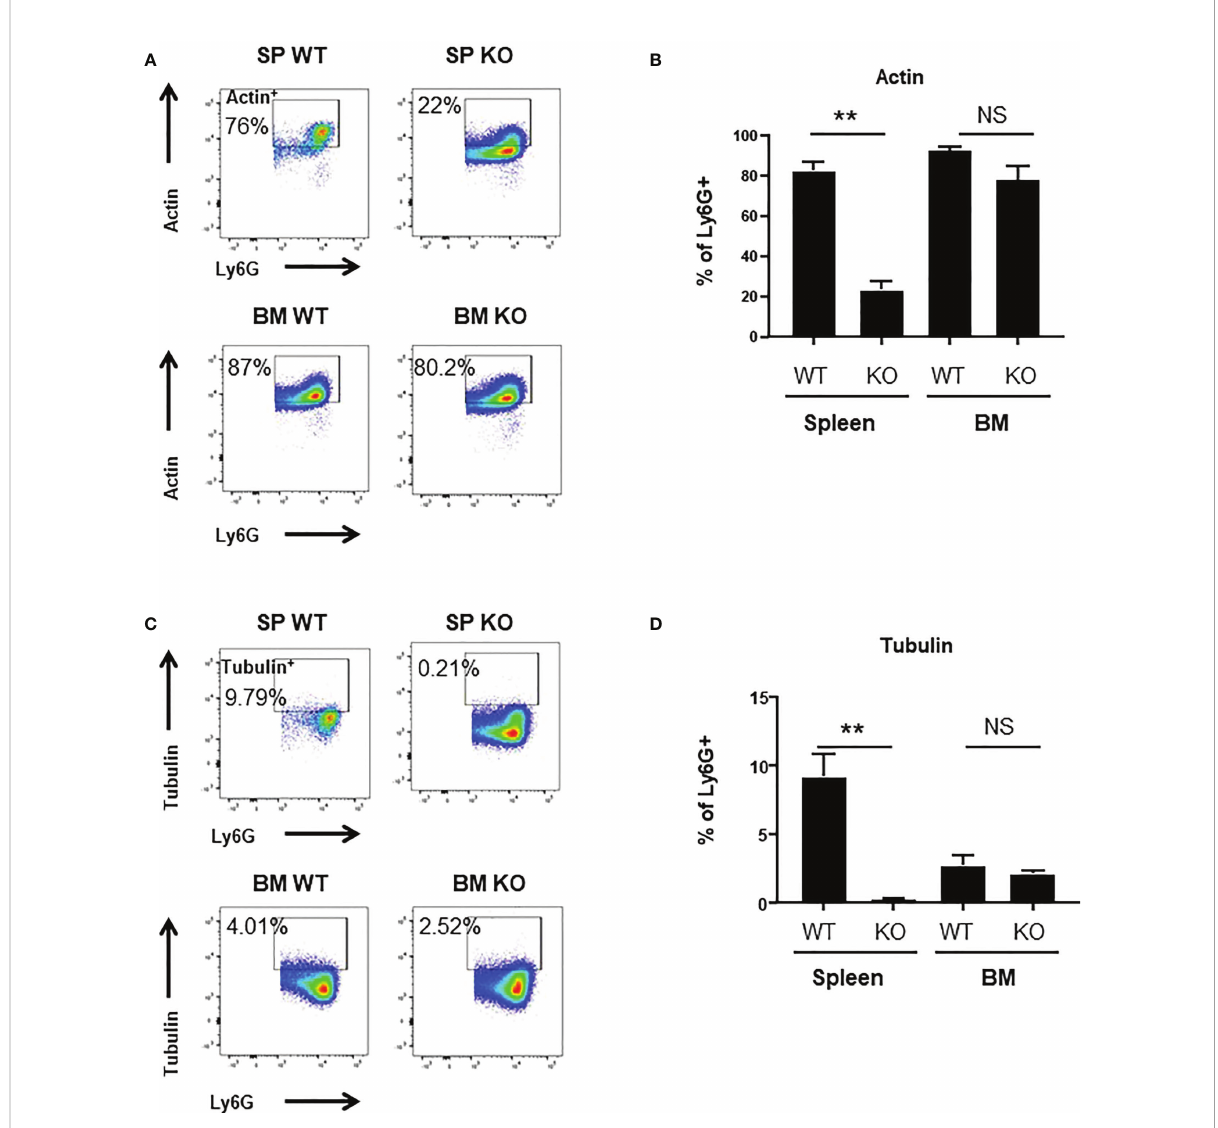
FIGURE 4 Decrease of Actin + and Tubulin + levels in spleen Cxcr2-/- . (A) Gating strategy to measure F-Actin levels (Actin + ) in CD11b+ Ly6G+ neutrophils. (B) Percentage of CD11b+ Ly6G+ expressing Actin (mean ± SEM of at least 6 animals; Mann-Whitney test, NS: non-signi fi cant, **p < 0.01). (C) Gating strategy to measure a -Tubulin levels (Tubulin + ) in CD11b+ Ly6G+ neutrophils. (D) Percentage of CD11b+ Ly6G+ expressing Tubulin. (mean ± SEM of at least 6 animals; Mann-Whitney test, NS: non-signi fi cant, **p <